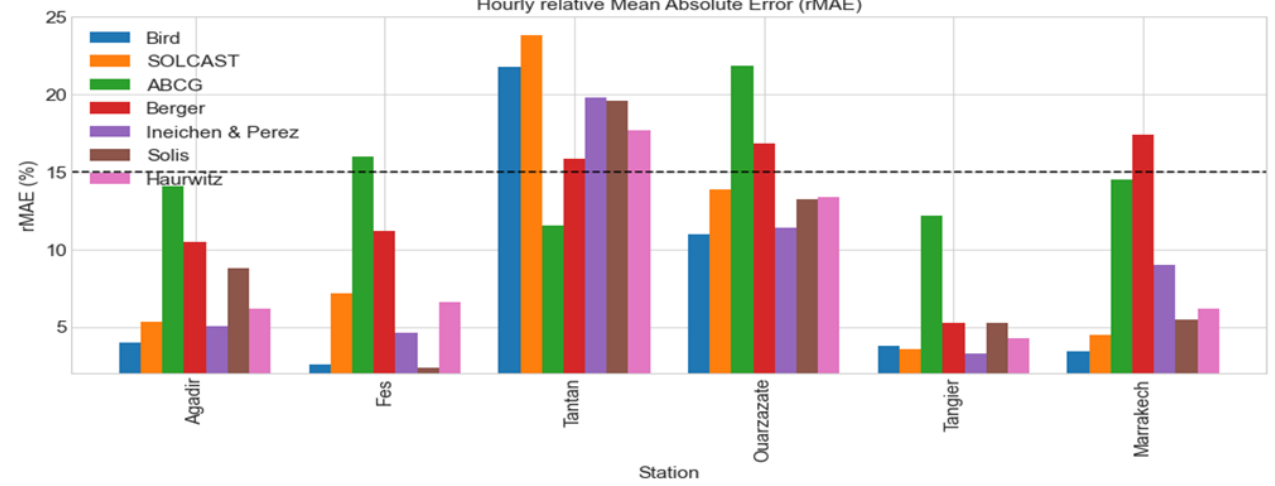
Figure 5. Hourly relative mean absolute error (rMAE) of modelled clear sky GHI against McClear clear sky GHI. Table 5. Hourly mean observed GHI (W/m 2 ) and coefficient of determination (R 2 ) of clear sky models against GHI measured in